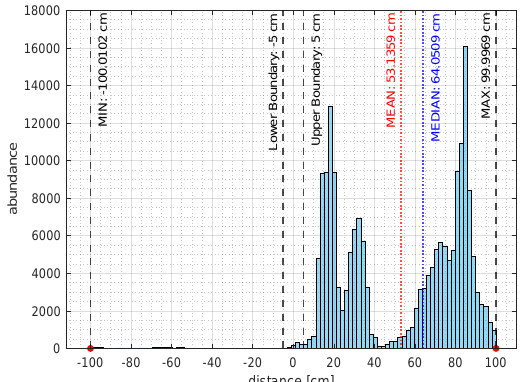
Figure 6. Distribution of the distances between the points and the surface of the large wall with the three balconies in Figure 7. This wall is occluded by a scaffolding with a typical width of around 75cm, accounting for the bimodal distribution.